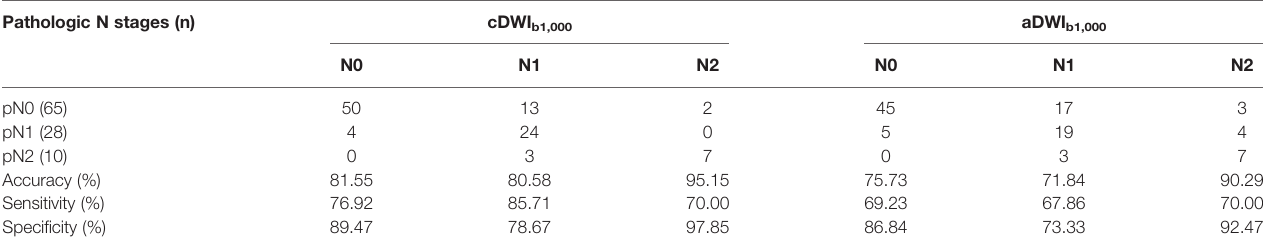
TABLE 3 | N staging of rectal cancer using cDWI b1,000 and aDWI b1,000 images. Pathologic N stages